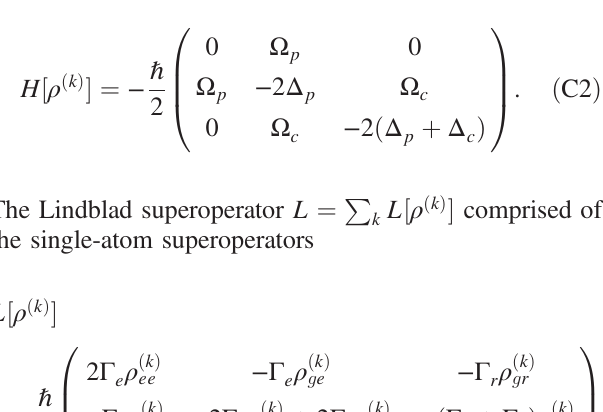
∝ N for the p R ¼ 37 ð 2 π × MHz Þ 2 as expected p; ð c Þ → Γ Γ 0 ð N r r þ R Þ